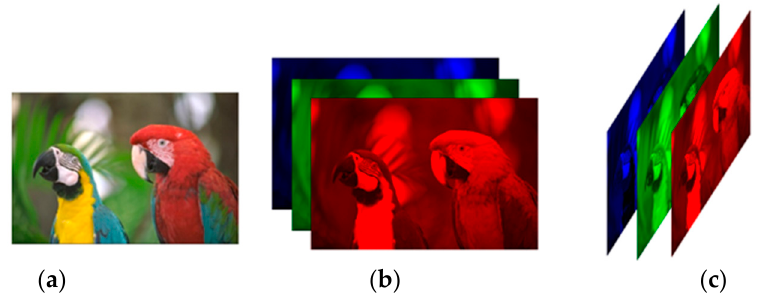
Figure 3. Two tensor representations of a color image. ( a ) image kodim23; ( b ) X 1 ∈ R n 1 × n 2 × 3 ; ( c ) X 2 ∈ R n 1 × 3 × n 2